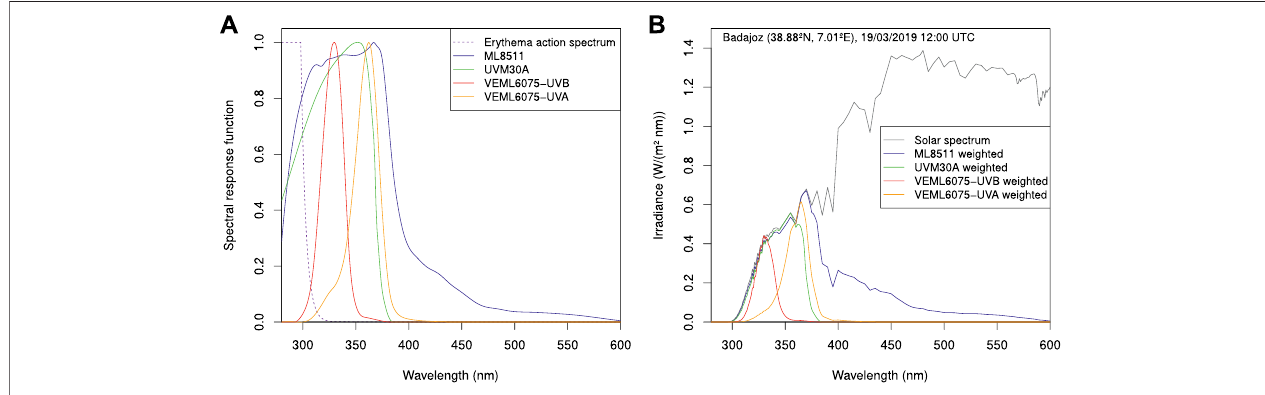
FIGURE2| SpectralresponsefunctionofsensorsML8511,UVM30A,VEML6075-BandVEML6075-A (A) ,andatypicalsolarspectrumweightedbytheirspectral response (B)